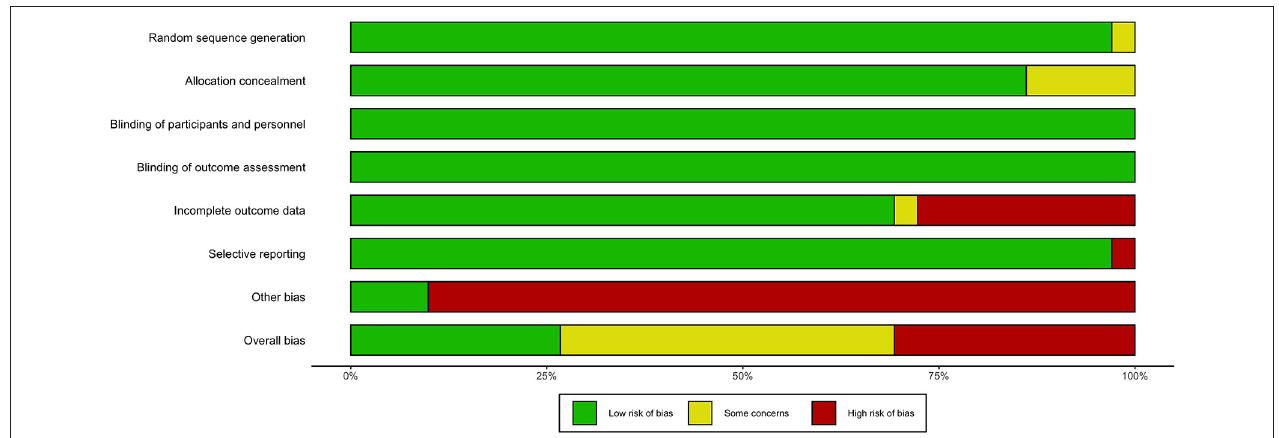
FIGURE 2 | Risk of bias summary of included studies.